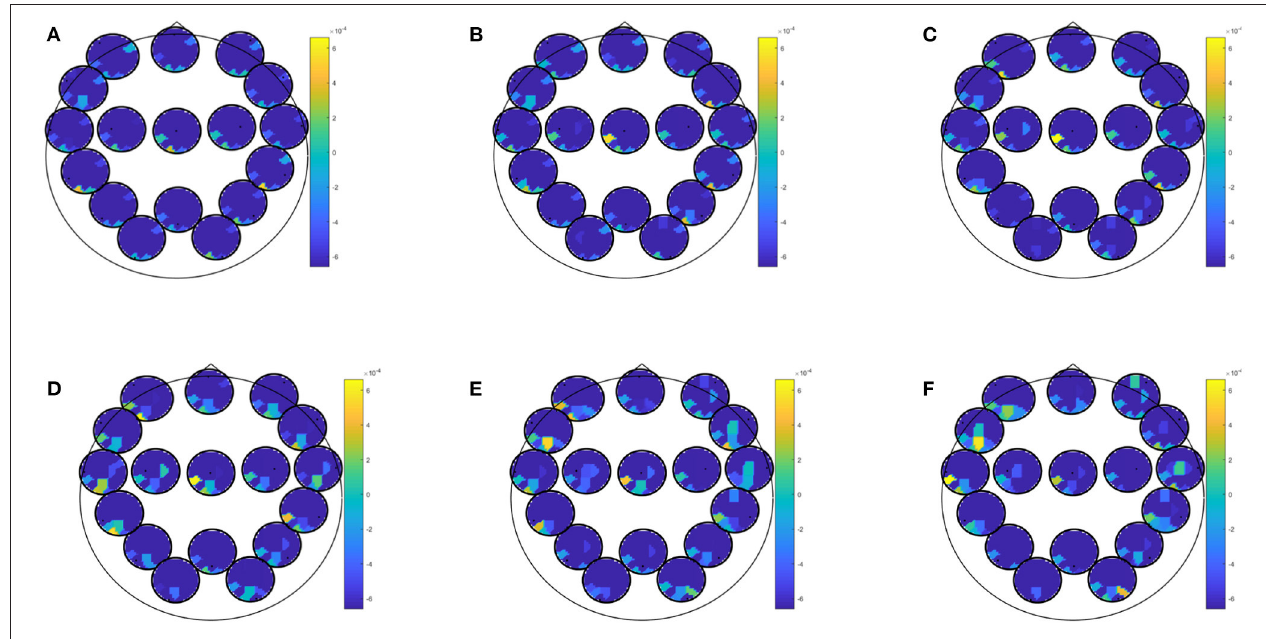
FIGURE 4 | Predictor coefficients β for questionnaire data combined with directed transfer function (DTF) extracted during rumination. Coefficients indicate importance of the feature to the model for the prediction of at least moderate worsening of depressive symptoms in winter. (A) Delta 1–4 Hz, (B) Theta 5–7 Hz,